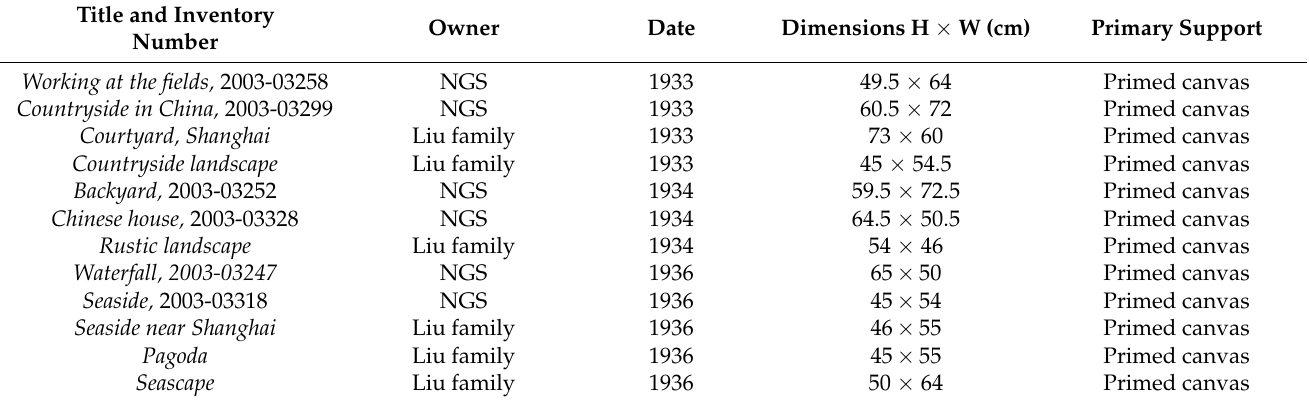
Table 1. Inventory and technical details of the studied